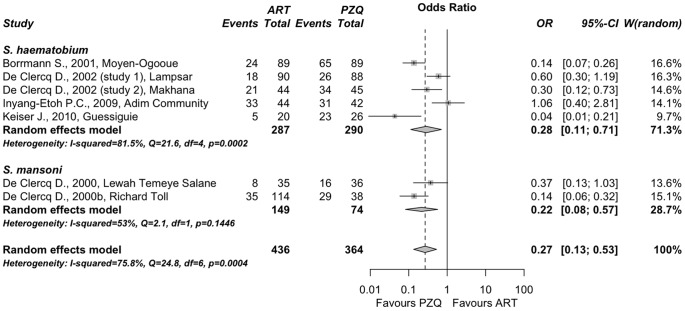
Forest plot of a random-effects subgroup meta-analysis comparing parasitological cure by artesunate as monotherapy vs. praziquantel.Points represent odds ratios with their corresponding 95% C.I. Intermediate diamonds are combined odds ratios for each subgroup and the diamond at the bottom is the overall combined odds ratio. The vertical line emphasizes an odds ratio = 1 (no difference) and the dashed vertical line shows the value of the overall combined odds ratio. The original reports are labeled with author name, year and location (for details see table 1).